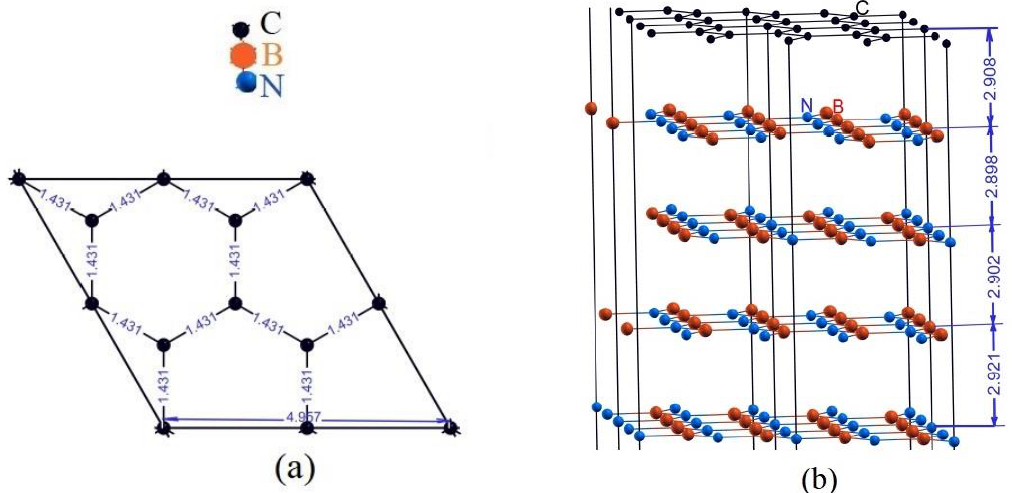
Figure 4. A-lattice structure after total relaxation. ( a ) Top view of the top layer and ( b ) lateral view.